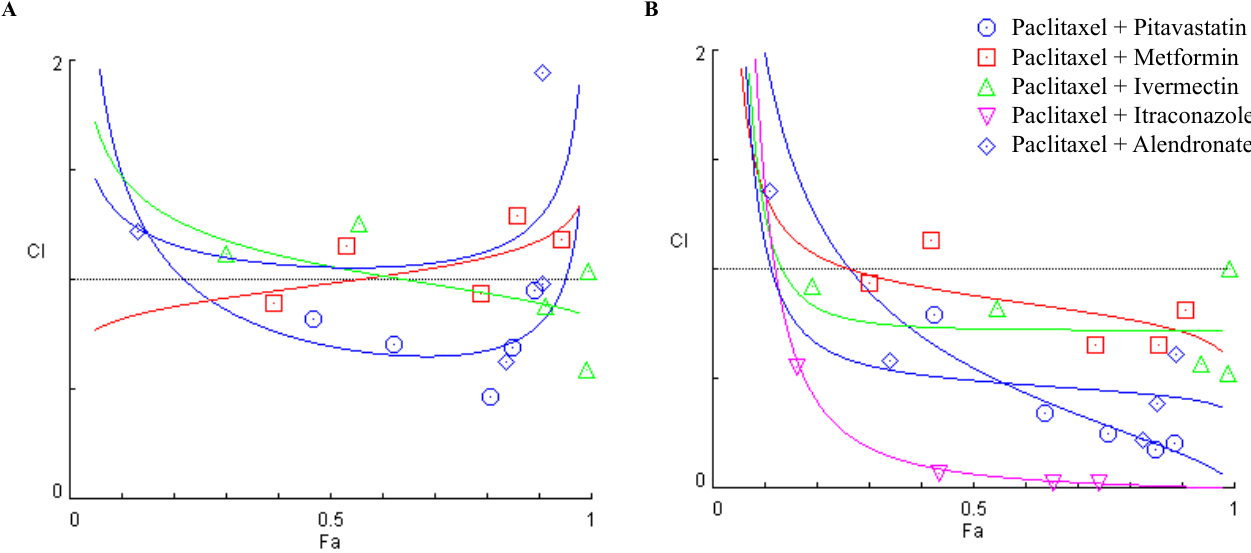
Figure 4. Combining Paclitaxel with repurposed drugs has a synergistic effect on chemoresistant high-grade serous carcinoma cells. ( A , B ) Chou–Talalay method effect level (Fa)—Combinatory Index (CI) plot showing drug synergism of ( A ) OVCAR8 and ( B ) OVCAR8 PTX R P cells, after exposure to a fixed-dose ratio that corresponds to 0.25, 0.5, 1, 2 and 4 times the individual IC 50 values each drug, e.g., Paclitaxel combined with Pitavastatin, Metformin, Ivermectin, Itraconazole and Alendronate for 48 h. The combined treatment was co-administered at the same time. All assays were performed in triplicate in at least three independent experiments. CI was plotted on the y-axis as a function of Fa on the x-axis to evaluate drug synergism. CI: <1 (synergism), =1 (additivity) and >1 (antagonism) Table 1. Fractional effect (Fa) values and respective combinatory index (CI) values showing drug synergism of OVCAR8 and OVCAR8 PTX R P cells, after exposure to a fixed ‐ dose ratio that corre ‐ sponds to 0.25, 0.5, 1, 2 and 4 times the individual IC 50 values of each drug for 48 h. The combined treatment was co ‐ administered at the same time. All assays were performed in triplicate in at least three independent experiments. CI > 1 (antagonism), CI = 1 (additivity) and CI < 1 (synergism, bold). OVCAR8 OVCAR8 PTX R P